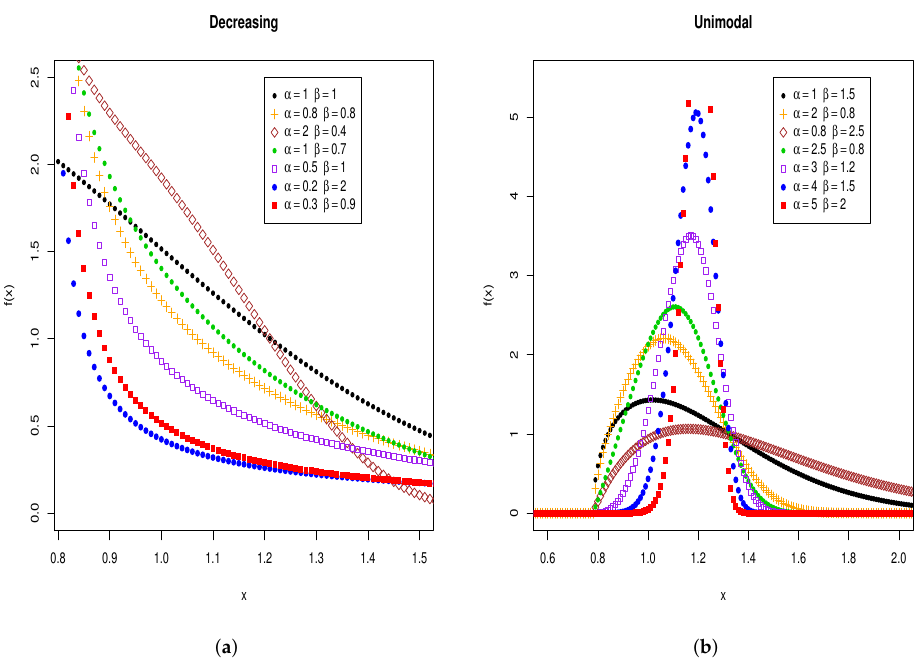
Figure 1. Plots of the density functions of the NEGLED when λ 1 = 2.0, λ 2 = 0.5 and λ 3 = 1.0, and ( a ) αβ < 1 or α = β = 1, λ 1 < λ 2